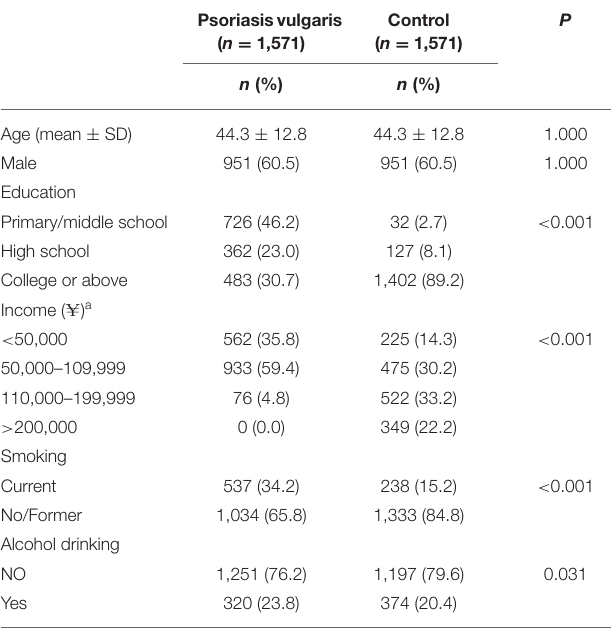
TABLE 1 | Characteristics of the cases and healthy